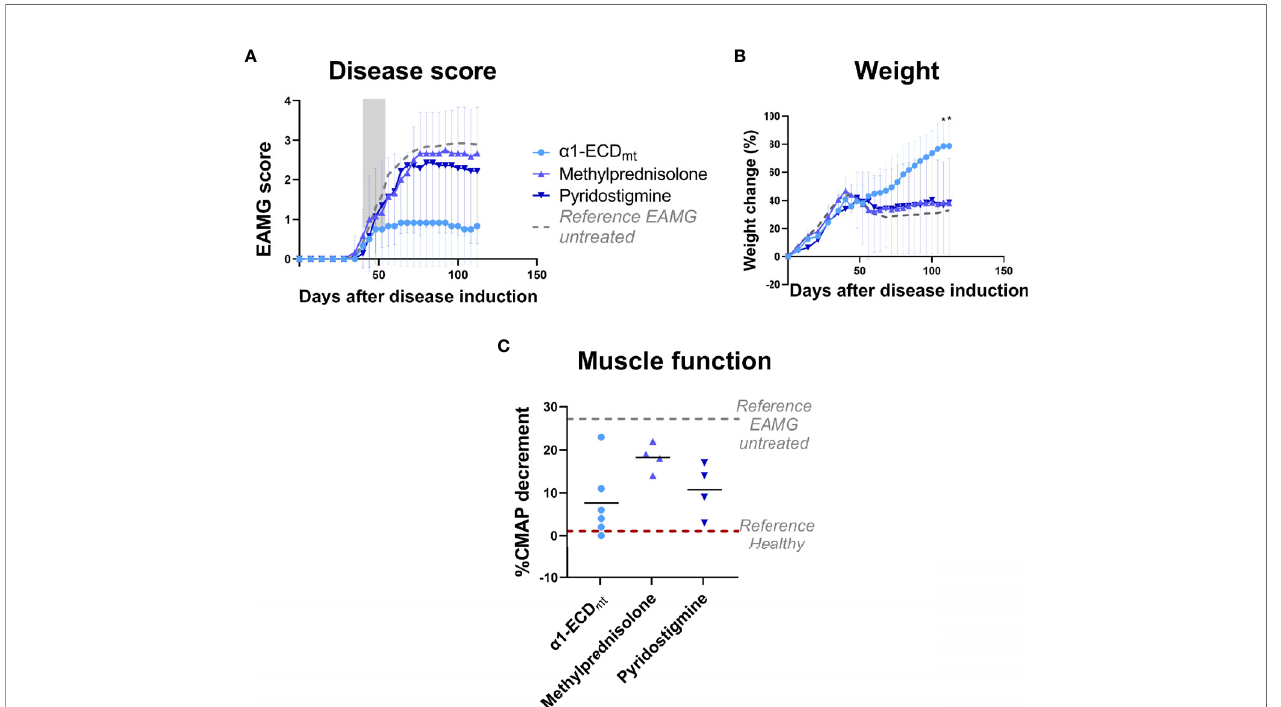
FIGURE 5 | EAMG treatment ef fi cacy of a 1-ECD mt is superior to that of two different active treatments for MG. EAMG rats were treated with either 5 mg/Kg methylprednisolone administered intraperitoneally (N = 7), 18,5 mg/Kg pyridostigmine administered orally (N = 6), or 1000 m g a 1-ECD mt administered intravenously (N = 6) on twelve consecutive days, starting at day 40 after disease induction. (A) Average EAMG scores (± SD); the grey bar indicates the treatment period. Circles correspond to a 1-ECD mt , triangles correspond to methylprednisolone and inverted triangles correspond to pyridostigmine. (B) Average percentage of body weight change (± SD). (C) CMAP decrement: each symbol corresponds to one rat and the bar shows the mean value. In (C) dotted lines represent untreated EAMG rats and healthy rats for reference. *Compares a 1-ECD mt and